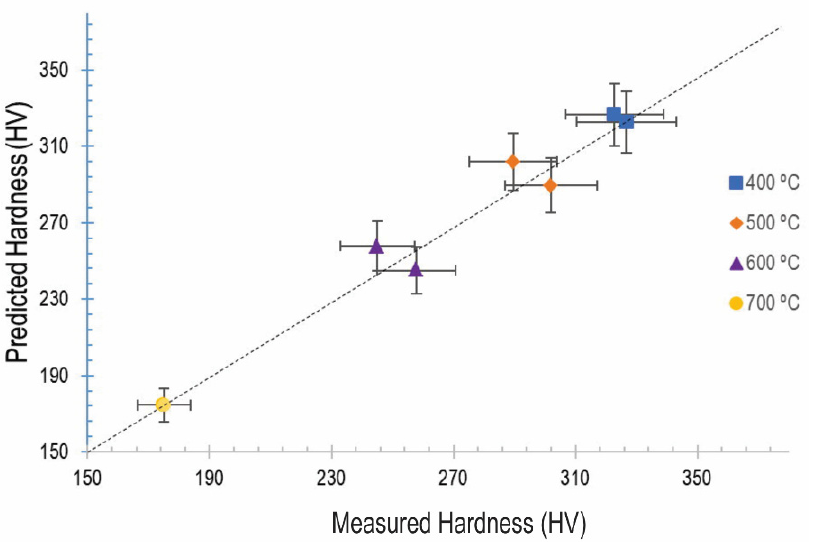
Figure 10. Comparison between the measured and the predicted hardness by the JMAK equation from the slow heating followed by rapid cooling condition.